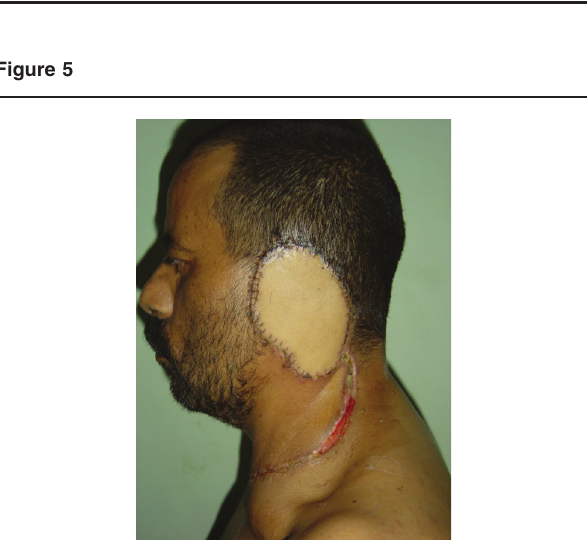
Early postoperative after temporal bone resection and pectoralis major myocutaneous flap reconstruction of patient